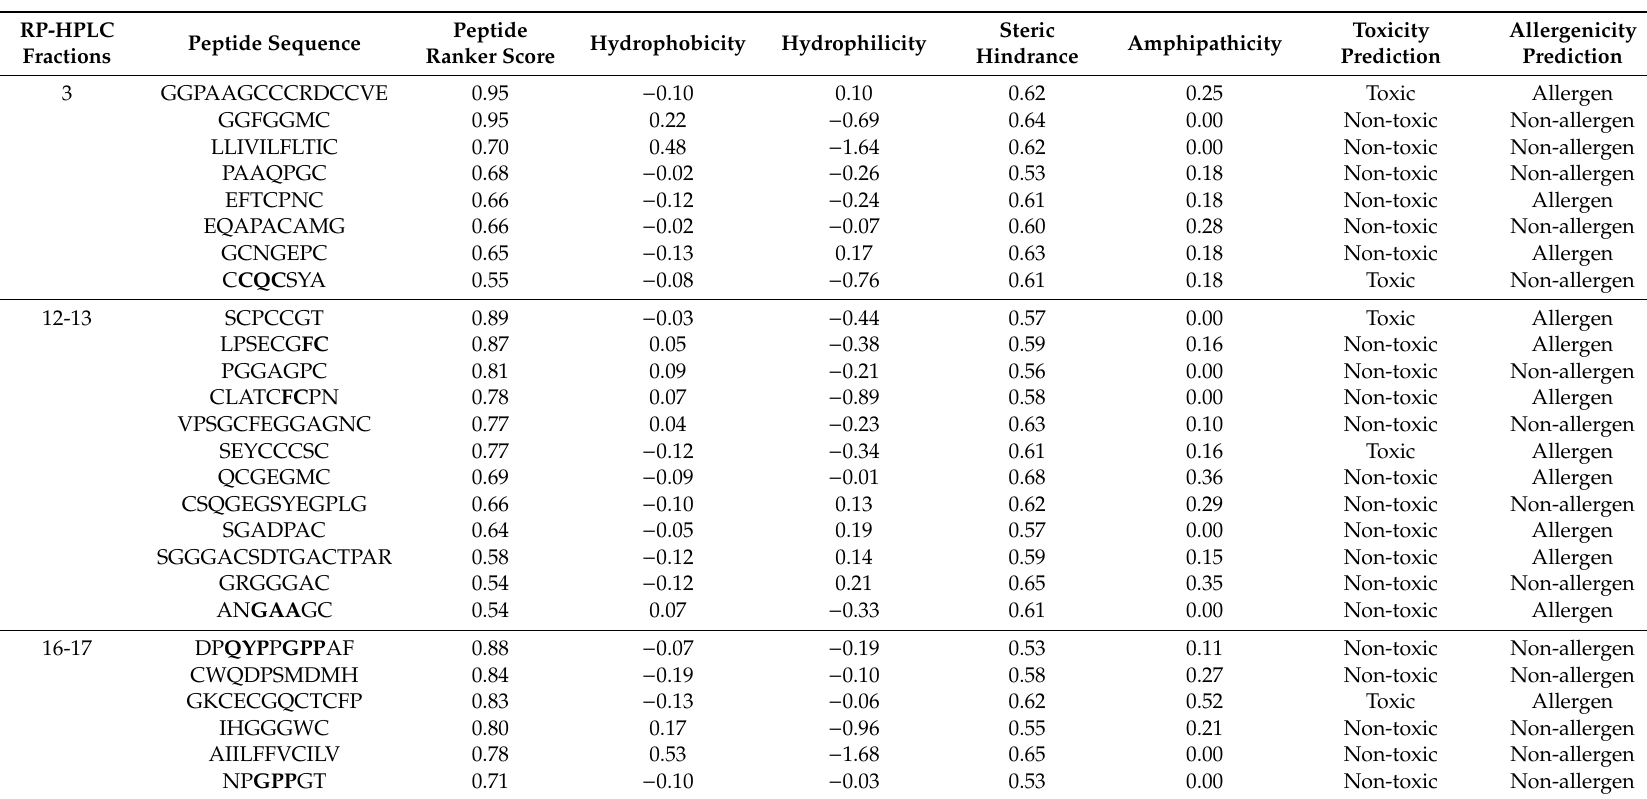
Table 1. In silico prediction of the physicochemical properties, toxicity, and allergenicity of the identified peptides with Peptide Ranker score > 0.5.